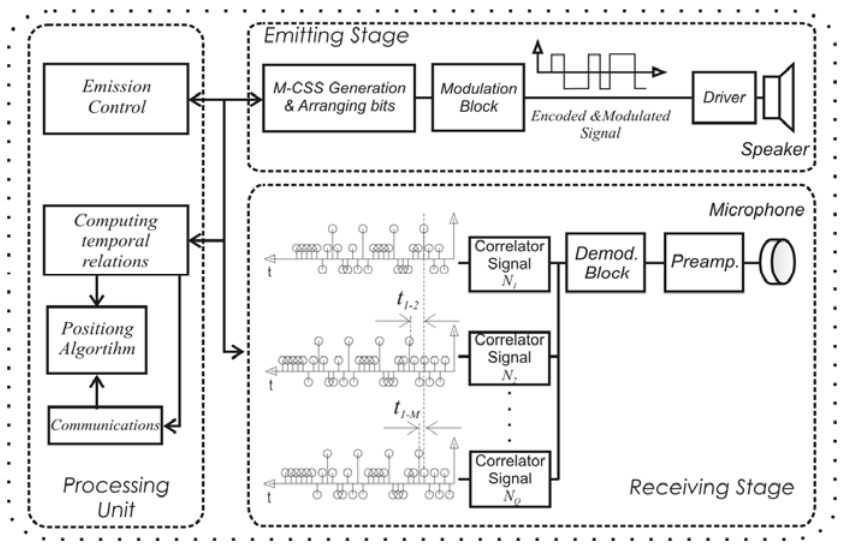
Figure 2. Detailed block diagram of node hardware